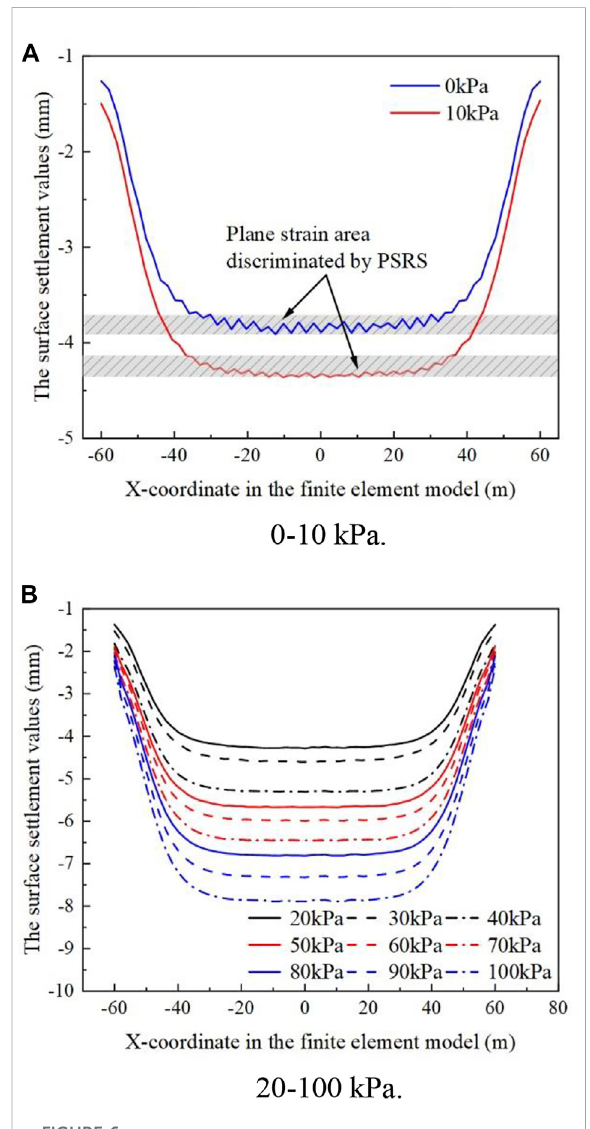
FIGURE 6 Development of spatial effect of the foundation pit under the symmetrical load of 0 – 100 kPa. (A) 0 – 10 kPa. (B) 20 – 100 kPa.